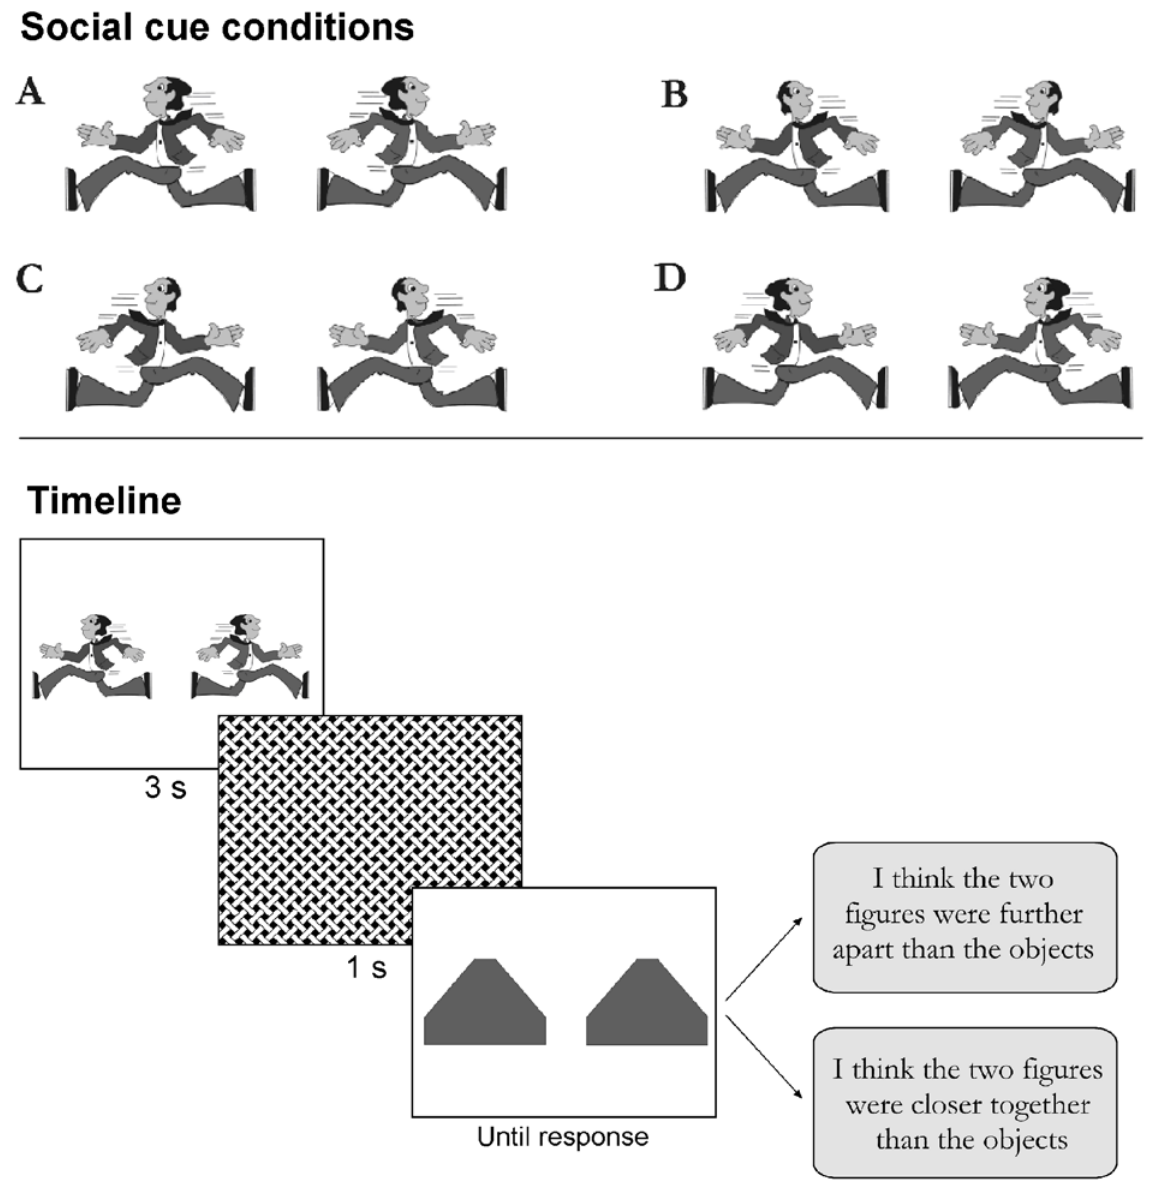
Figure 1. Response to social cues. Top panel: Left to right: increasing strength of social cues leading to the response: ‘Cartoons Closer’. Bottom panel: Example of a single trial. each cartoon figure. The figures had been digitally adapted such that the mass distribution on either side of the vertical midline was identical, with the eye positioned exactly at the midline of the figure and centred in the head. However, the wind caused the jacket and tie to adopt a sideway position resulting in a slight asymmetry in mass distribution. Although this slight asymmetry in mass distribution is unrelated to this study, it is important to briefly mention as it resulted in an independent low-level illusion (also observed in pilot data: Jellema et al. , 2004). This low-level illusion is attributable to a less massive appearance due to spaces in the running cartoons than the corresponding pyramidal-shaped geometrical objects. Therefore the least massive objects will be judged furthest away from the observer, and thus inferred to be furthest away from each other. For that reason we expect that,